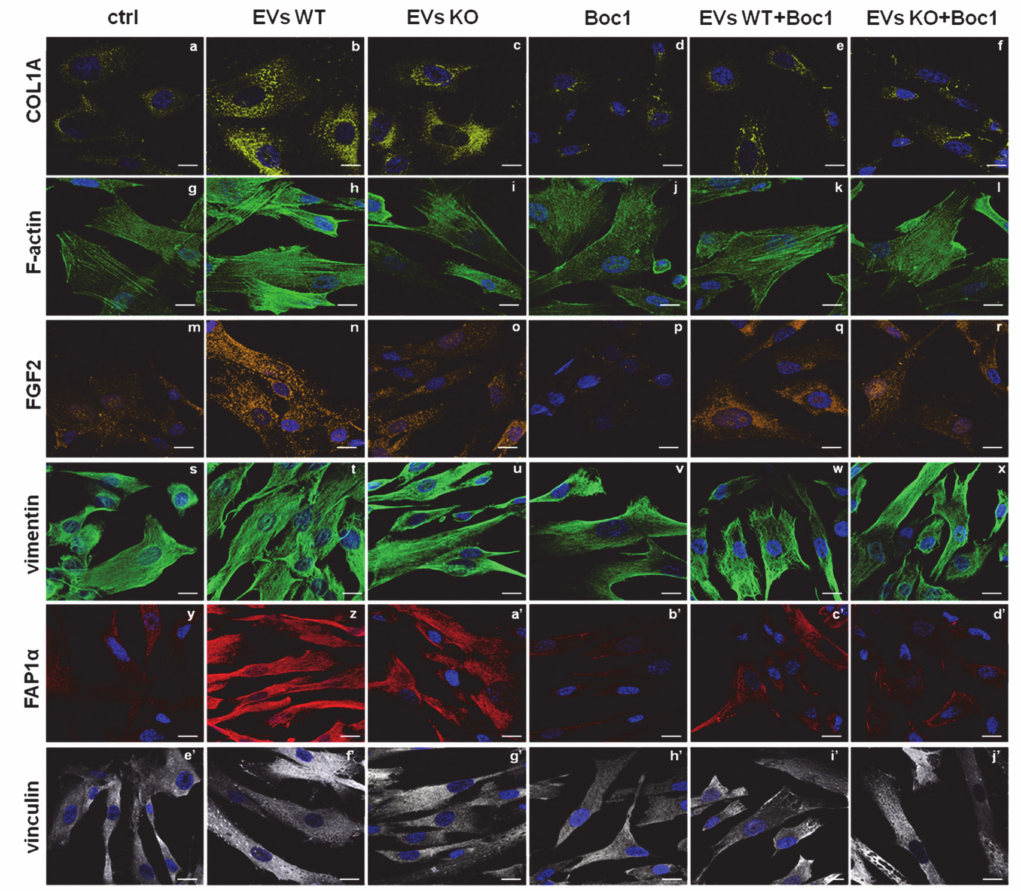
Figure 5. Fibroblasts activation induced by ANXA1-containing EVs. Immunofluorescence analysis on BJ cells to detect: COL1A (panels a – f ), F-actin (panels g – l ), FGF2 (panels m – r ), vimentin (panels s – x ), FAP1 α (panels y – d’ ) and vinculin (panels e’ – j’ ). Nuclei were stained with Hoechst 33,342 1:1000 for 30 min at RT in the dark. Magnification 63 × 1.4 NA. Bar = 100 µ